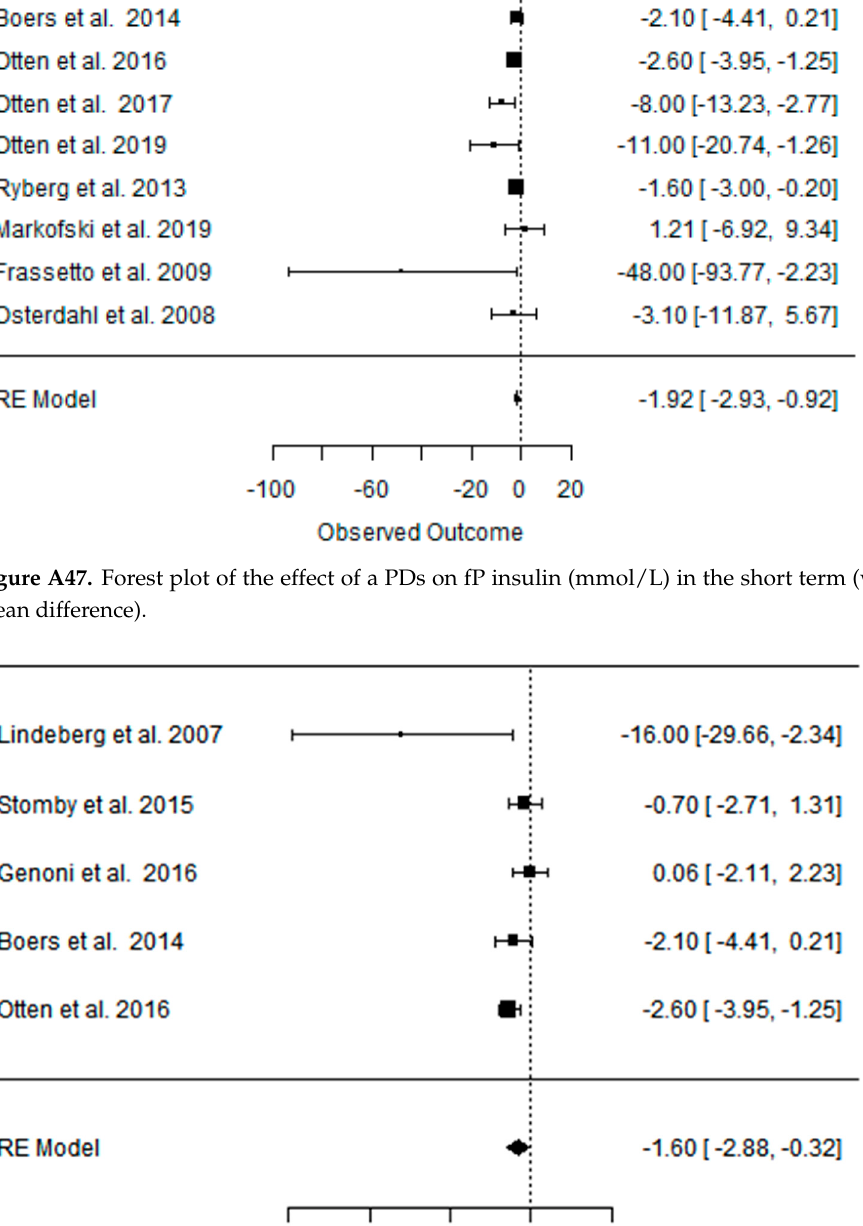
Figure A48. Forest plot of the effect of PD on fP insulin (mmol/L) in the short term (weighted mean difference).